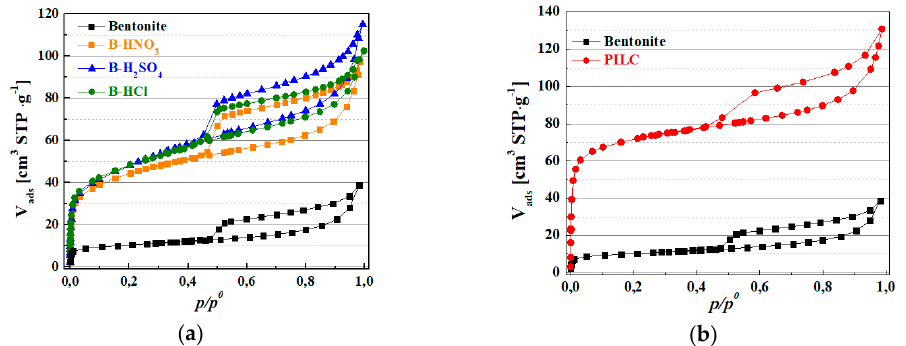
Figure 3. N 2 adsorption-desorption at − 196 °C for raw bentonite: ( a ) B-H 2 SO 4 , B-HNO 3 , B-HCl; ( b ) raw bentonite and PILC.